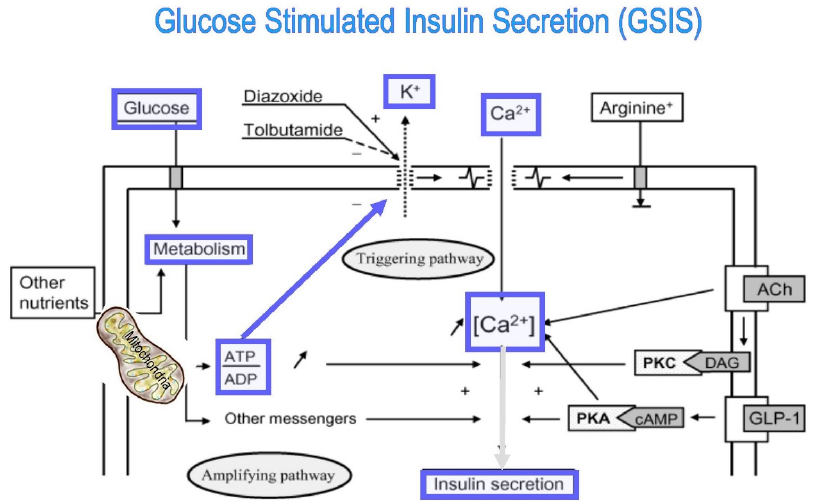
Figure 2. Glucose-stimulated insulin secretion (GSIS), the triggering pathway, includes entry of glucose into β -cells, acceleration of glucose metabolism, increase in ATP content and ATP/ADP ratio, closure of ATP-sensitive K + channels (K ATP channels), membrane depolarization, opening of voltage- dependent Ca 2+ channels (VDCCs), increase in Ca 2+ influx through VDCCs, raised intracellular Ca 2+ concentration ([Ca 2+ ] i), and exocytosis of insulin granules. Figure 3. Glucose depends on insulin to enter the peripheral tissues, muscles, and fat. Without insulin, glucose stays in the blood, causing diabetes. The increase in blood glucose concentration triggers insulin secretion. Blood glucose levels, brown graph; the increase in blood glucose level triggers a prompt and parallel increase in insulin secretion, pink graph. With time, blood glucose